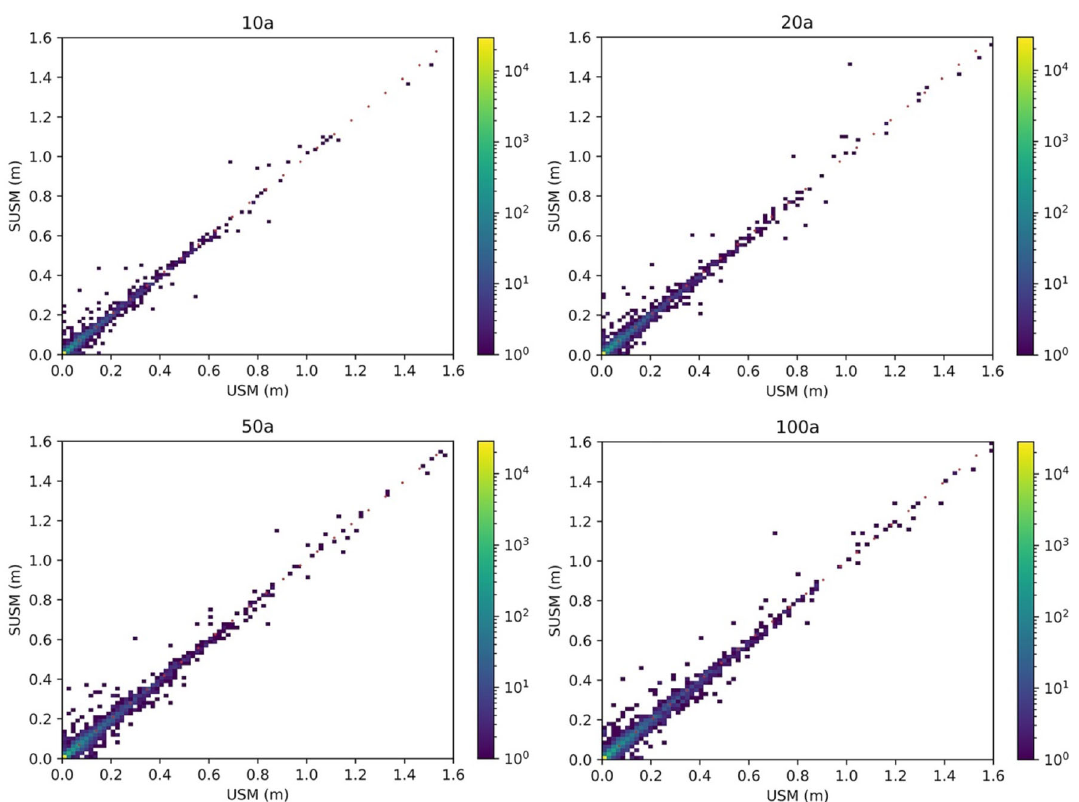
Fig. 11 2D histograms of the water depth, which present the density of raster cells in the four rainfall return periods. The x - and y -axes represent the water depth simulated by the urban stormwater model